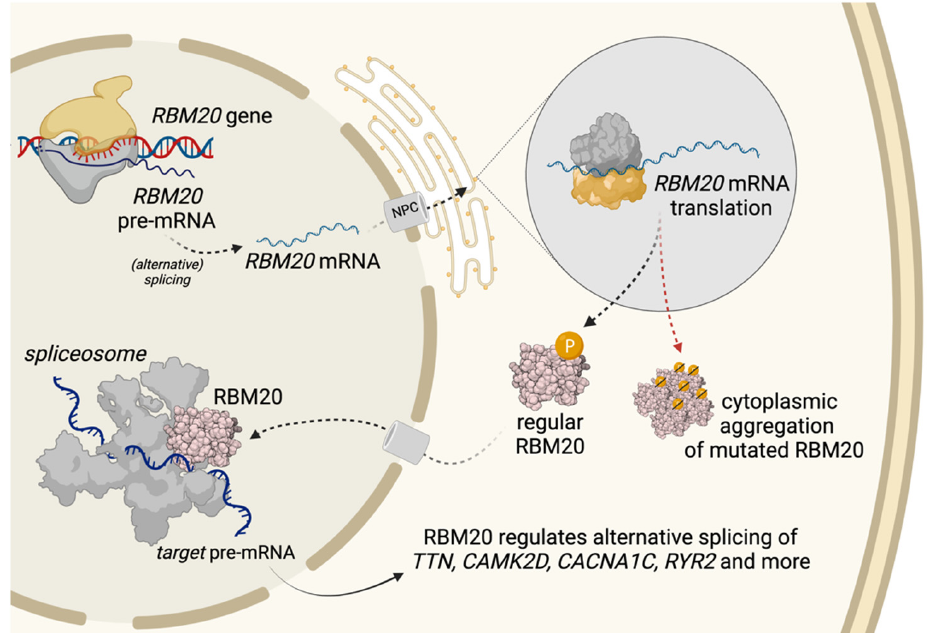
Figure 2. Modified from Schneider et al., 2019 [22]. RBM20 synthesis, trafficking and pathological cytoplasmic aggregation of RBM20-mutations. RBM20 is transcribed and its mRNA translocated through the nuclear pore complex (NPC) to the cytoplasm, where the RBM20 protein is translated. Regular RBM20 is transported back to the nucleus where it regulates alternative splicing as a part of the spliceosome. Disruption of nuclear transport processes in the presence of RBM20 mutations, however, may promote cytoplasmic protein aggregation, amongst other things by aberrant phosphorylation of the RS-Domain. This caused mislocalization may explain the altered splicing of target genes in the presence of RBM20 mutations.